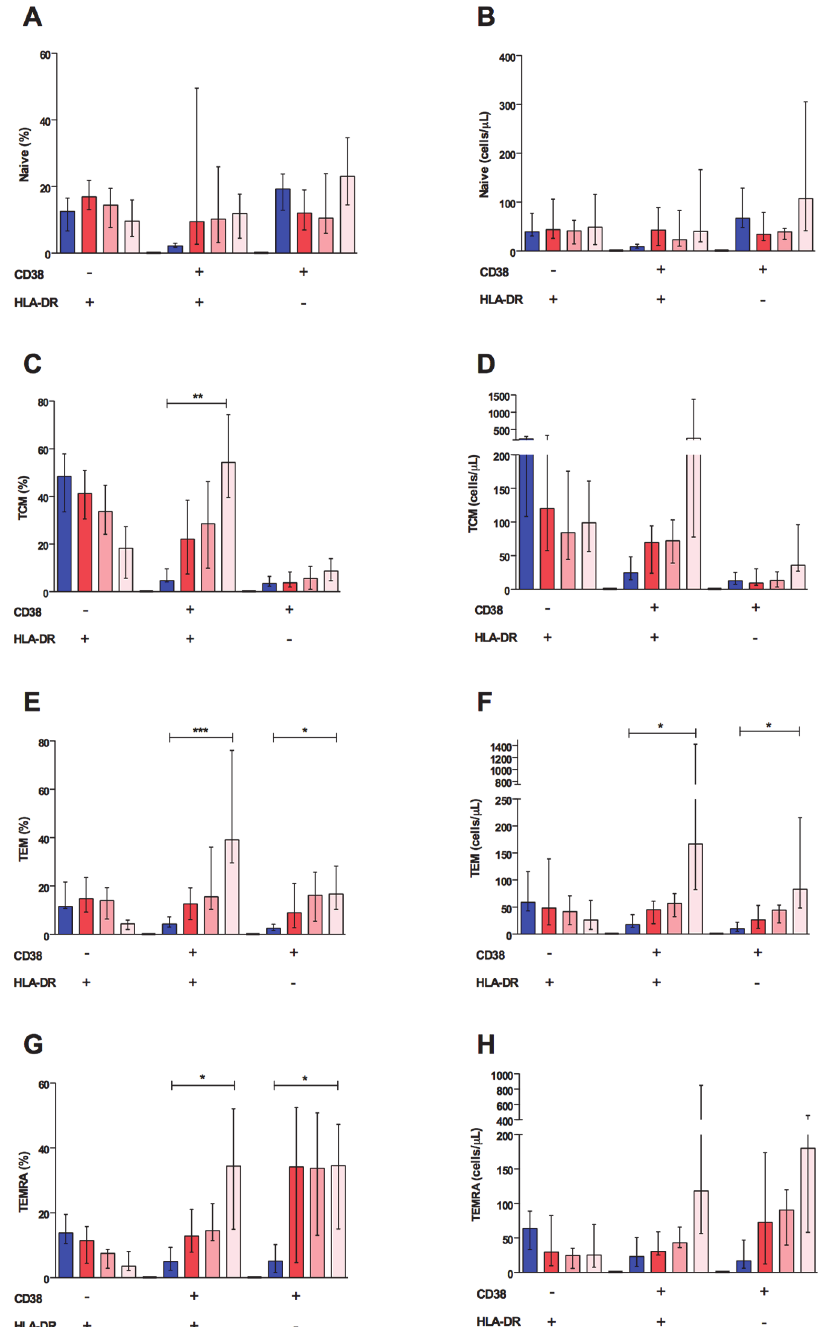
Fig 5. Activation of CD8+ T cells subpopulations in dengue fever. Percentage and absolute numbers of na ï ve (A and B), central memory (C and D), effector memory (E and F), and terminal effector memory (G and H) T CD8+ cells are shown. Increased percentages of activated cells were observed mostly in dual positive CD38+HLA-DR+ central memory (TCM) (p < 0.001) effector memory (TEM) (p < 0.0001) and terminal effector memory (TEMRA) (p < 0.01) T cells, although the percentage of CD38+HLA-DR- effector memory (p < 0.01) and terminal effector (p < 0.01) T cells were also augmented in dengue fever.